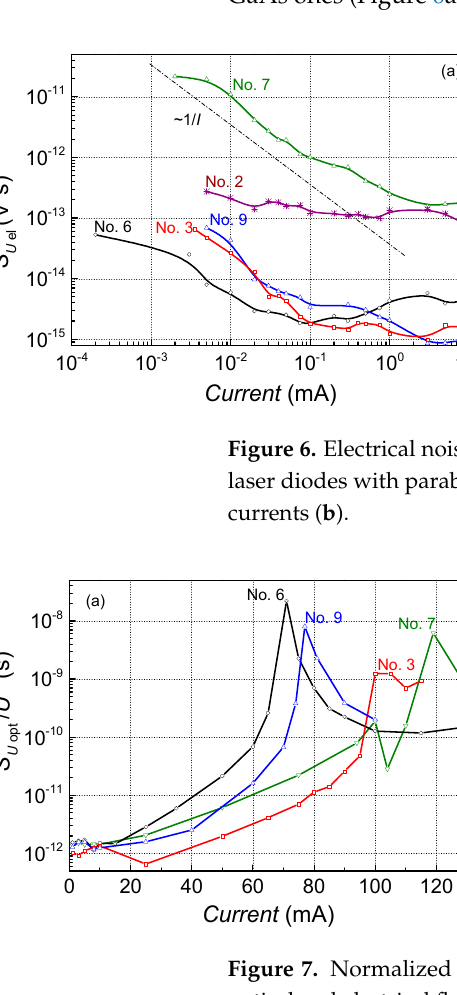
current at room temperature for laser diodes with parabolic and rectangular optical and electrical fluctuations in the 10 Hz–20 kHz frequency range ( b ) dependencies on forward